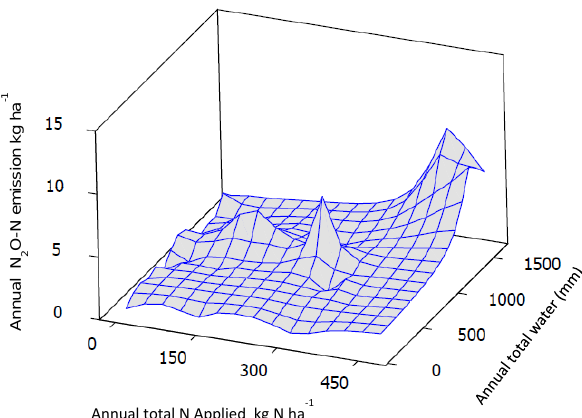
Fig. 5. The relationship between N 2 O emissions and annual total rainfall plus irrigation and total N input across the arable site net-